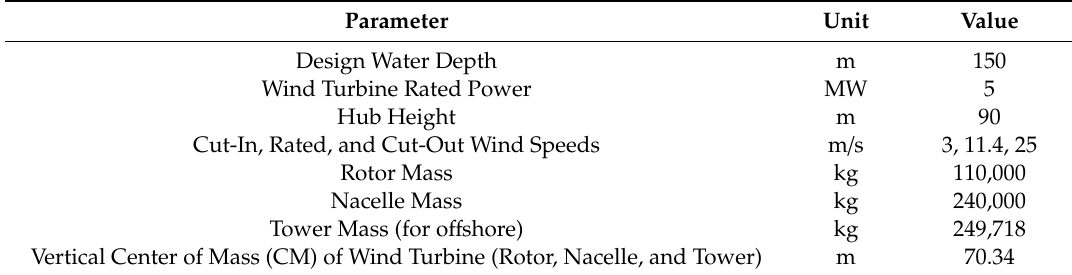
Table 1. Wind turbine